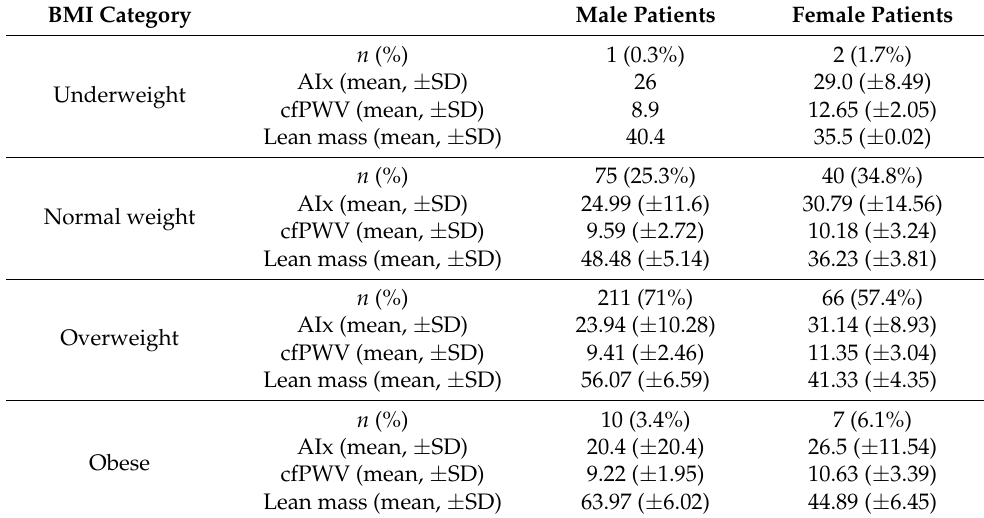
Table 3. Patient characteristics II.